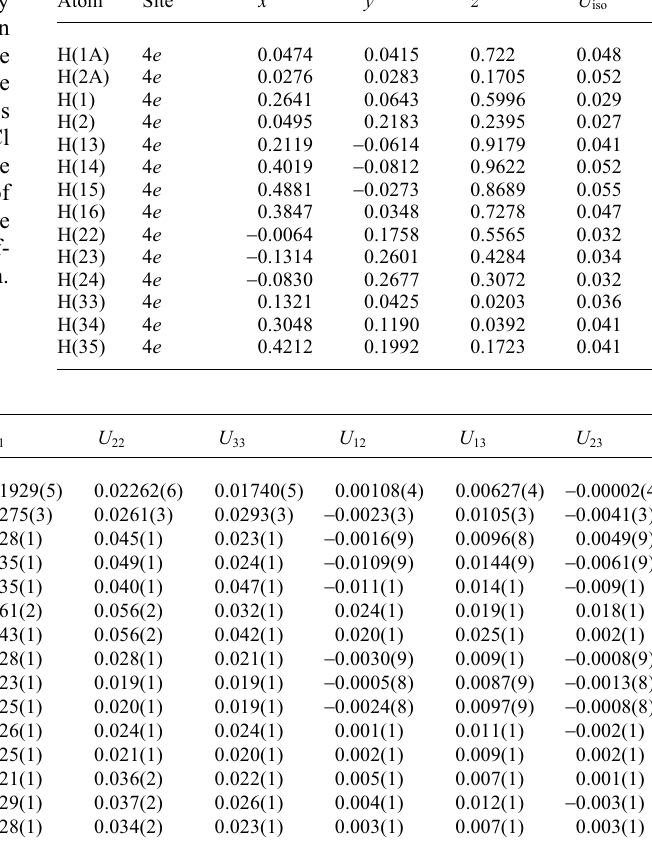
Table 2. Atomic coordinates and displacement parameters (in Å 2 ) .